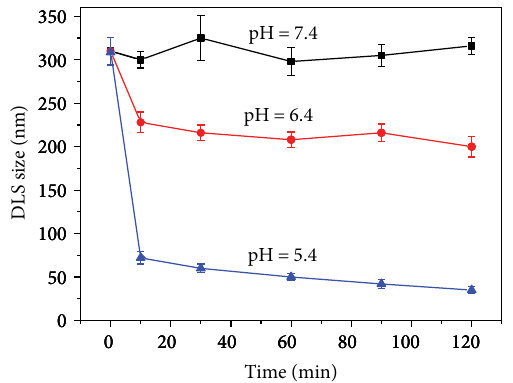
Figure 2: (a) Zeta potentials during the manufacturing process of the mesoporous CaCO nanoparticles, CS: CS coating, SA: SA coating, GA: GA coating, PEG: PEG coating, FA: FA coating). (b) FT-IR pure mesoporous CaCO 3 spectra of different layer coating MCNs.